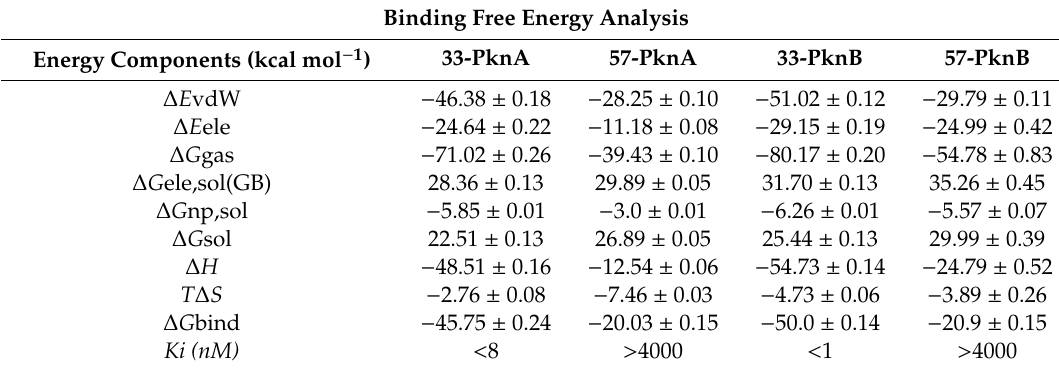
Table 3. Binding free energy profiling of 33- and 57- PknA and PknB complexes. Binding Free Energy